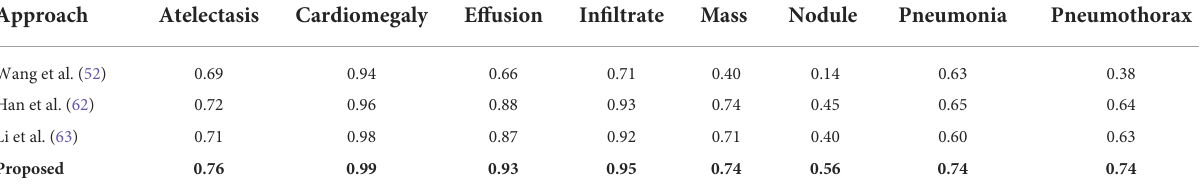
TABLE 8 Comparison of latest techniques in terms of the IOU